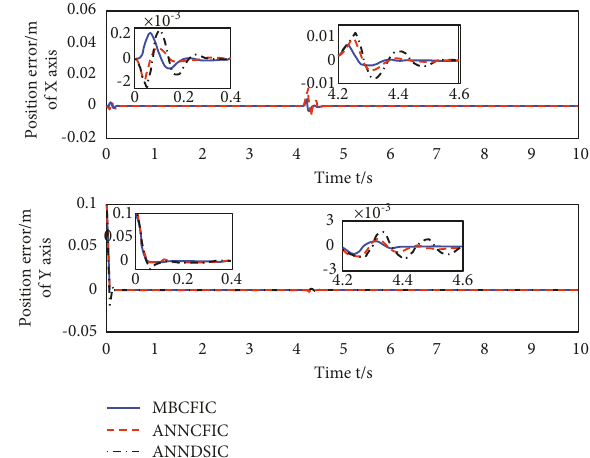
Figure 6: Comparison of position tracking errors of three control schemes.